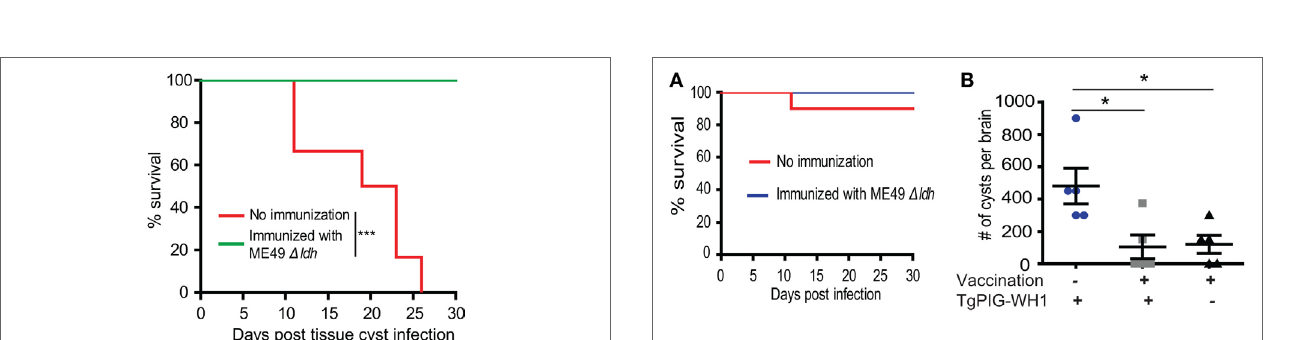
FigUre 4 | Δ ldh mutant immunization prevented cyst formation from further infections. (a) ICR mice were pre-immunized with ME49 Δ ldh as in Figure 2 and 30 days later challenged with 10 4 tachyzoites of TgPIG-WH1. Non- immunized mice were included as control and survival of mice were monitored for another 30 days ( n = 10 mice for each strain). (B) Cyst loads in the brains of non-immunized but TgPIG-WH1 challenged mice, immunized and TgPIG-WH1 challenged mice, and Δ ldh immunized but not TgPIG-WH1 challenged mice [not shown in (a) ]. The mice survived at day 30 in (a) were sacrificed, and the number of Toxoplasma cysts in the brain homogenate was determined by DBA-FITC staining and fluorescent microscopy. Data from the analysis of five mice in each group were graphed, * p < 0.05, Student’s t -test.